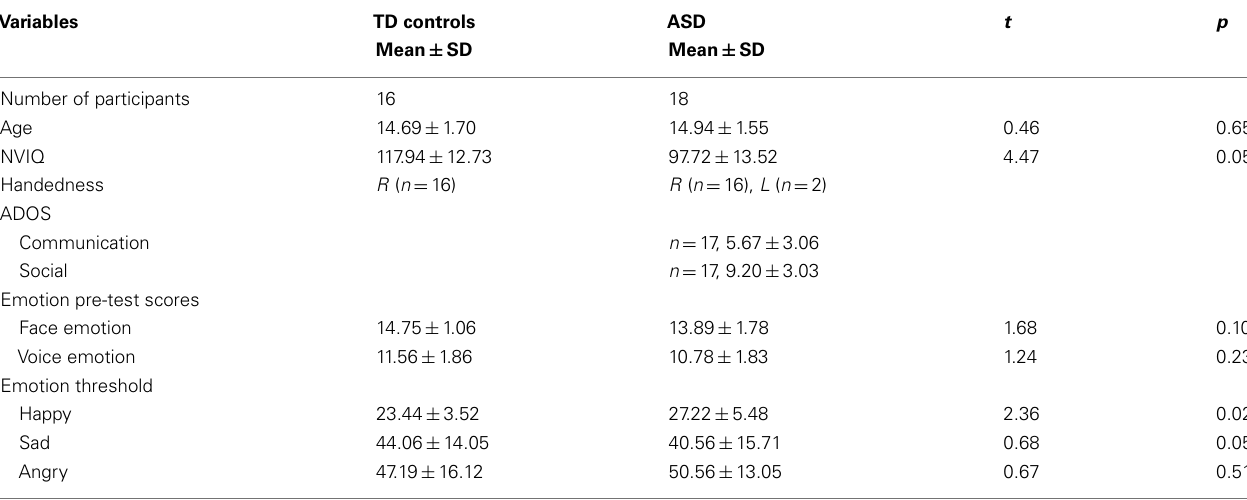
Table 1 | Participant characteristics.